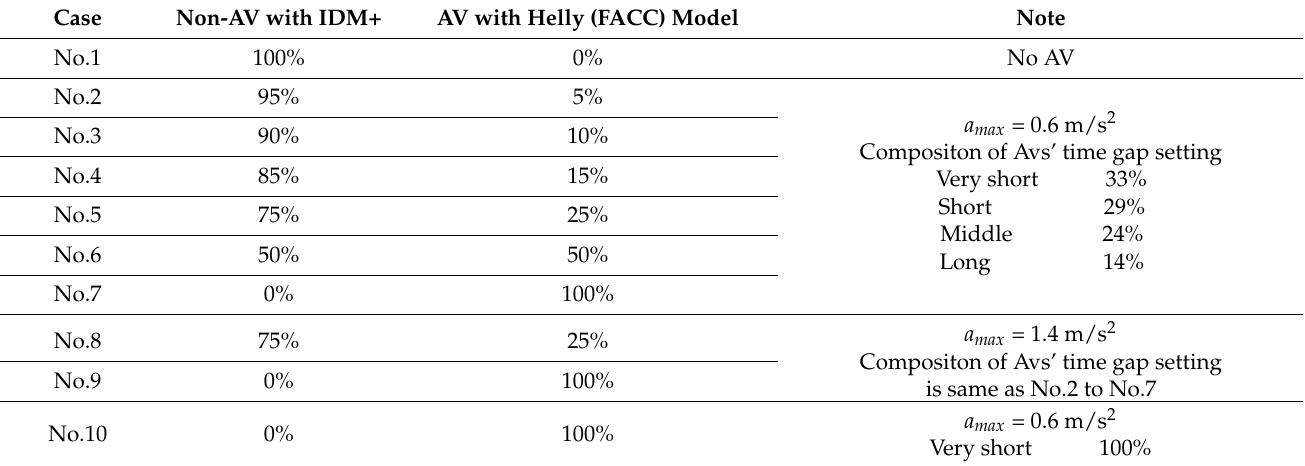
Table 3. Summary of ten case